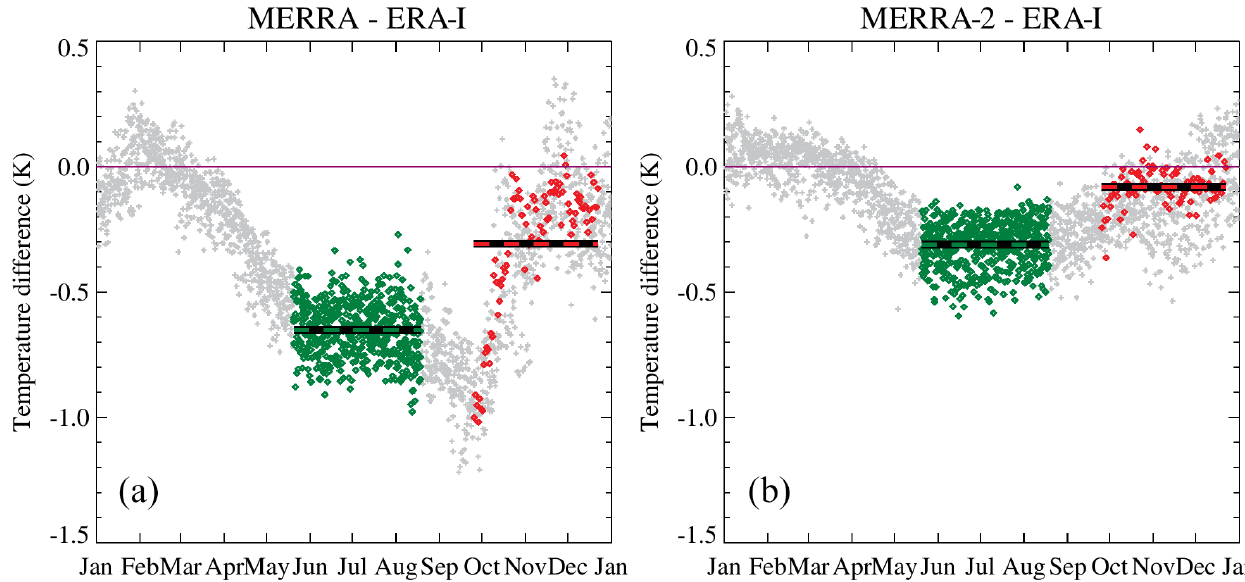
Figure 18. Daily mean temperature differences (gray, not smoothed) of MERRA (a) and MERRA-2 (b) relative to ERA-I at 62hPa (repre- sentative of the balloon float heights) in the 60 ◦ Antarctic polar cap for 2008–2013. The green–black dashed line indicates the mean of the 2008–2013 differences (green symbols) in the PSC analysis window. The red–black dashed line indicates the mean of the differences (red symbols) over the time span of 90% of the balloon